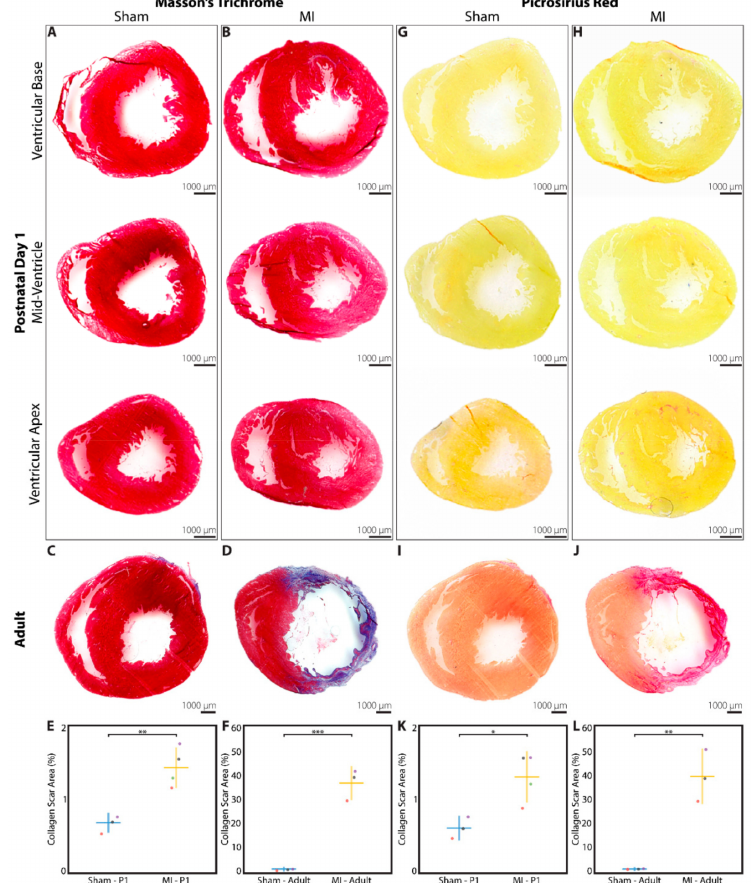
Figure 4. Collagen scar assessment of rat hearts at 3 weeks after sham surgery or induction of myocardial infarction (MI), performed in neonates on postnatal day 1 (P1) or in adults. Masson’s trichrome staining revealed minimal collagen scar after ( A ) P1 sham ( n = 3) and ( B ) P1 MI surgery ( n = 4), assessed at 3 levels below the level of suture placement. Significant collagen scar was detected after ( D ) adult MI ( n = 3) compared to ( C ) adult sham surgery ( n = 3). Collagen scar area relative to left ventricular area was quantified for neonates ( E ) and adults ( F ). Picrosirius red staining revealed minimal collagen scar after ( G ) P1 sham ( n = 3) and ( H ) P1 MI surgery ( n = 4), assessed at 3 levels below the level of suture placement. Significant collagen scar was detected after ( J ) adult MI ( n = 3) compared to ( I ) adult sham surgery ( n = 3). Collagen scar area relative to left ventricular area was quantified for neonates ( K ) and adults ( L ). * indicates p < 0.05. ** indicates p < 0.01. *** indicates p < 0.001. Horizontal lines indicate mean. Vertical lines indicate standard